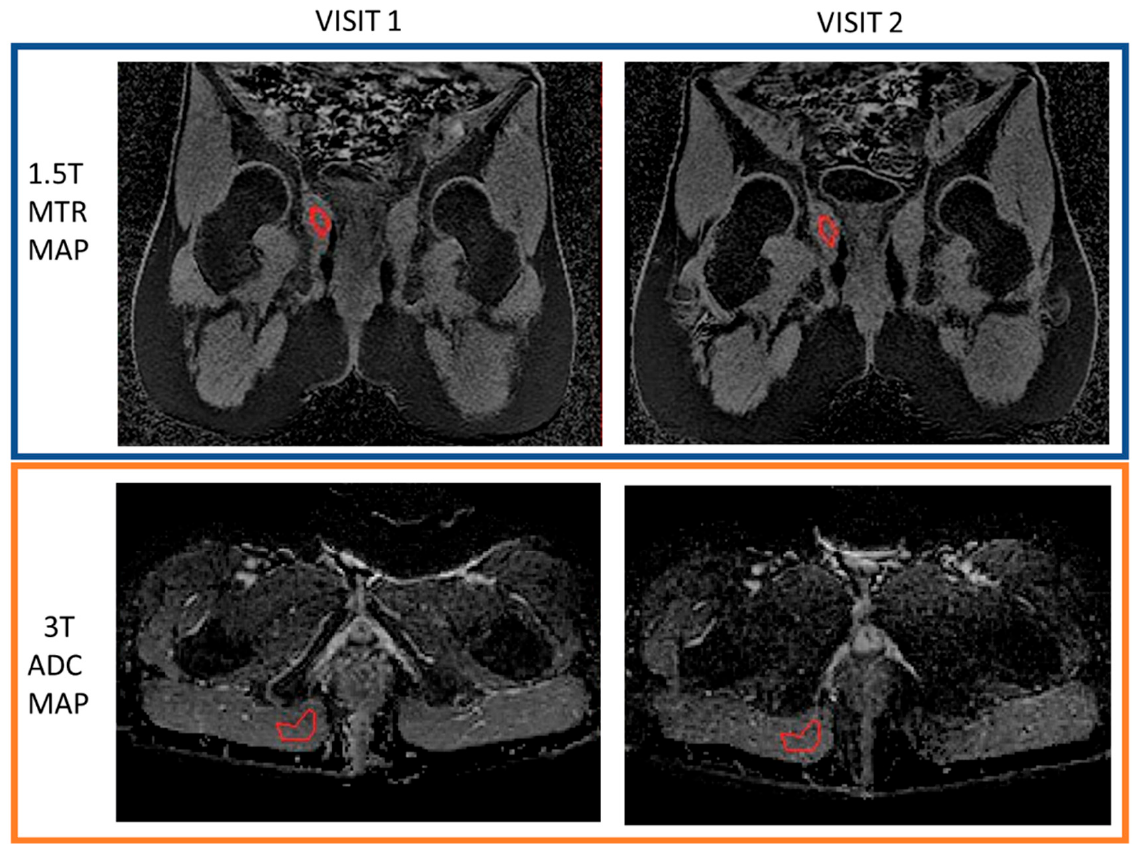
Figure 3. An example of muscle area ROIs drawn on MTR (1.5 T) and ADC (3.0 T) maps for both visits.